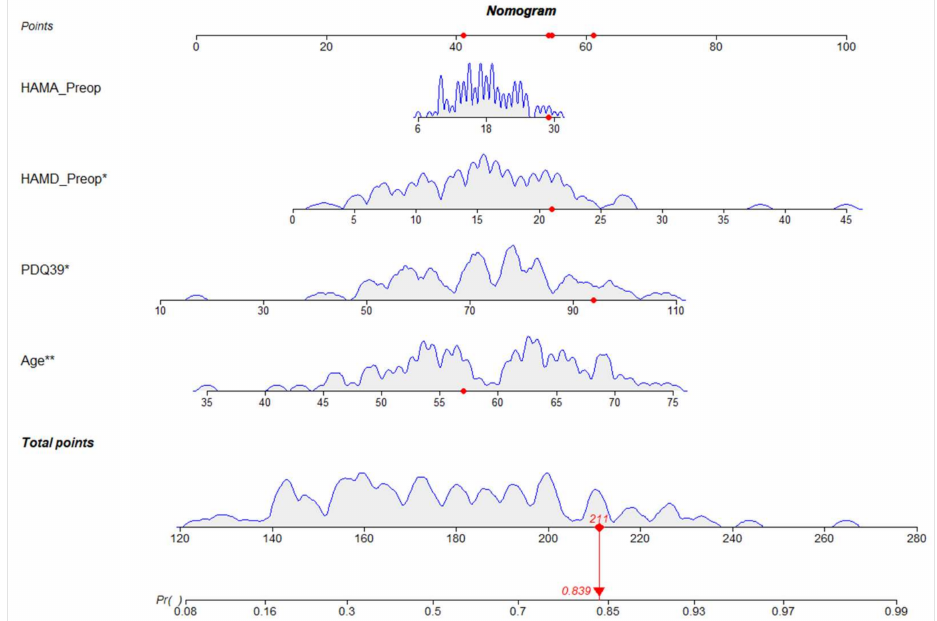
Figure A2. Nomogram to predict improvement of HAMD score after STN-DBS for PD. Clinical factor corresponds to a specific point by drawing a line straight upward to the points axis. After the sum of the points is located on the total points axis, the sum represents the probability of getting higher HAMD score improvement rate. * p < 0.01 ** p <